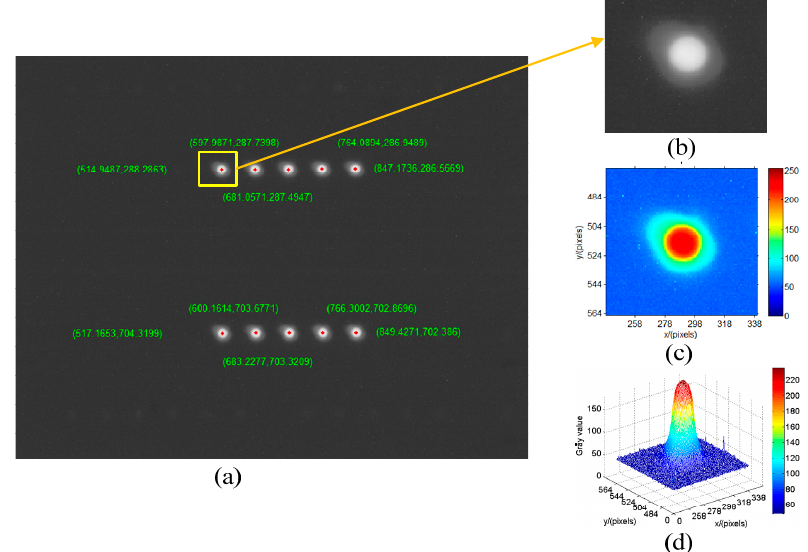
Figure 15. Captured image ( a ); and ( b – d ) gray scale, color scale, and 3D plots, respectively, of the same detailed view of one point.